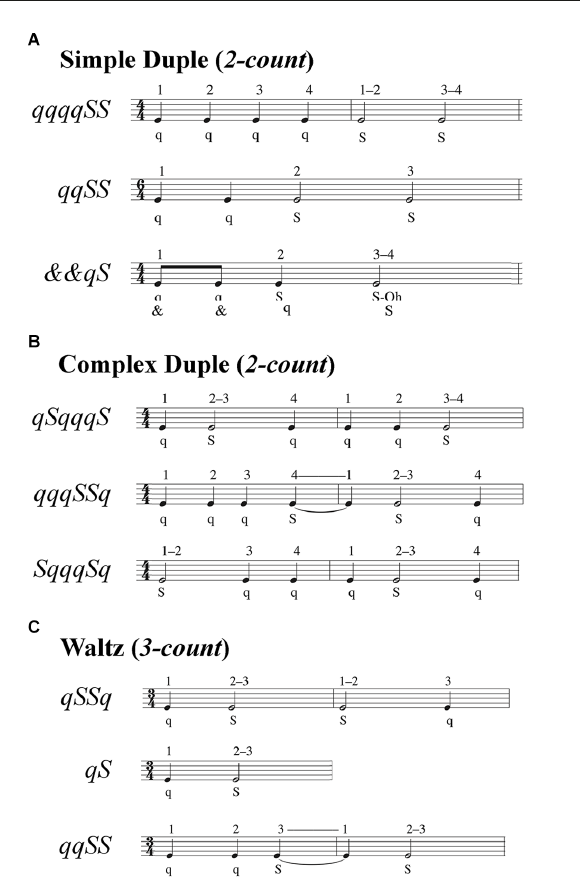
FIGURE2 Step sequences for temporal and spatiotemporal gait modifications. Step sequences consisted of two, four, or six steps. Each sequence specified a combination of very quick ( & = half-beat), quick ( q = one beat), and slow ( S = two beats) steps. The numbers above the musical bars show the beat count for each rhythm. (A) Simple duple sequences used a two-count rhythm in which the strong beat was the downbeat. (B) Complex duple sequences also used a two-count rhythm, but the strong beat was not the downbeat. (C) Waltz sequences used a three-count rhythm, such that sequences spanned either one or two